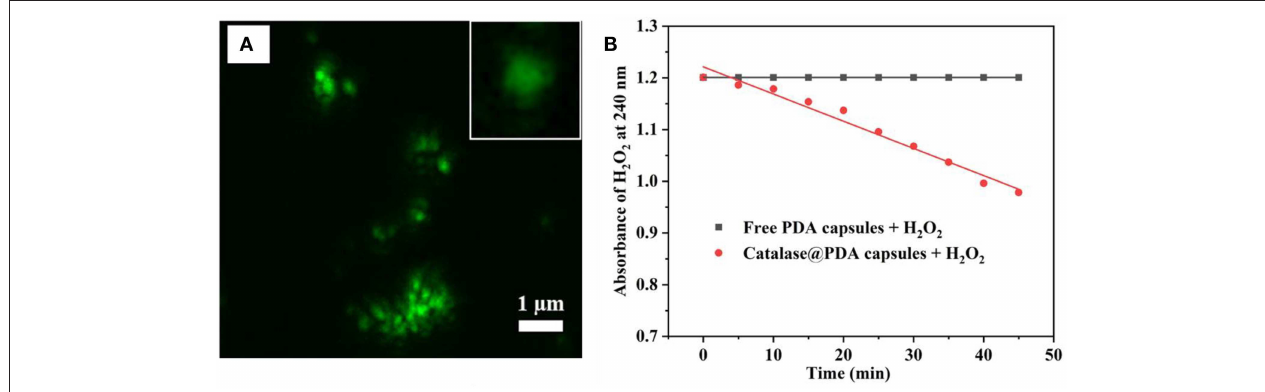
FIGURE 7 | CLSM image of FITC-catalase@PDA capsules and single FITC-catalase@PDA capsules (inset) (A) , and catalytic activity of catalase toward 10mM H 2 O 2 (B)